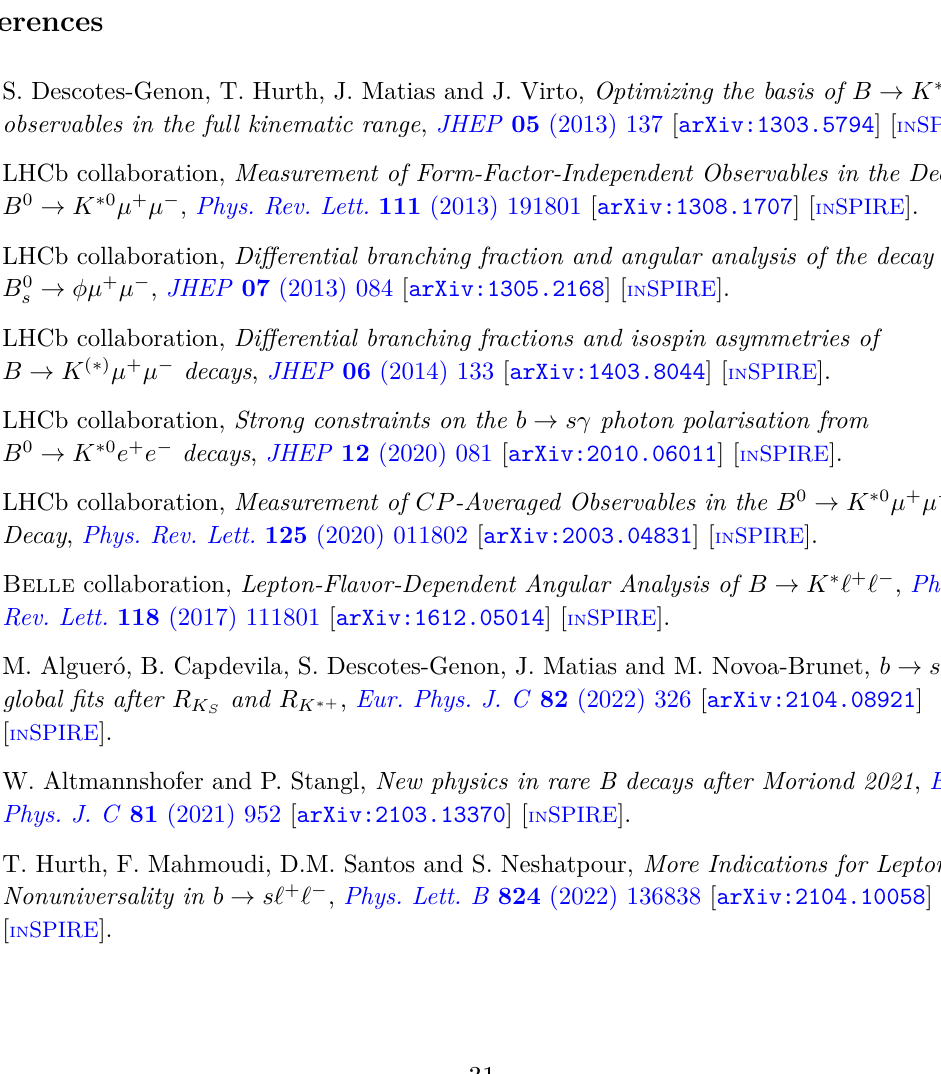
Figure 9 . Variation with θ of h A (2); CP comparison, the selected NP scenarios are shown without taking into account meson-mixing